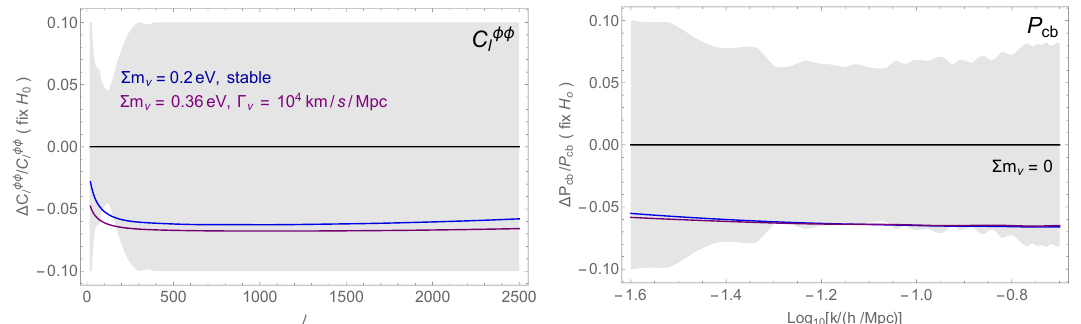
Figure 3 . The fractional di(cid:11)erences in the CMB-lensing potential C (cid:30)(cid:30) spectrum P cb ( right ) for an unstable (purple) and a stable (blue) neutrino scenario with respect to the case of massless neutrinos (black) at (cid:12)xed H 0 . The grey regions show the 1 (cid:27) uncertainties from Planck and SDSS DR7